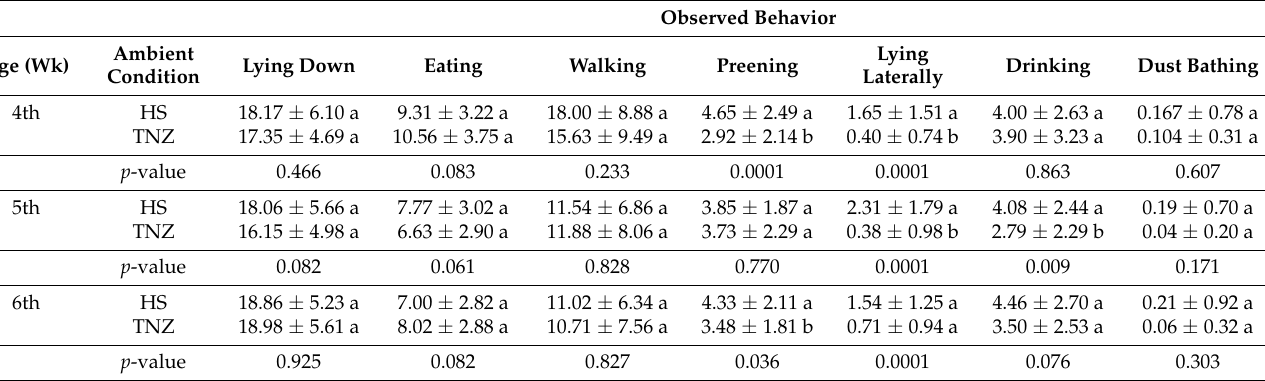
Table 4. Average frequencies of observed behaviors under HS and TNZ compared by the Tukey test during the 4th, 5th, and 6th week of growth.